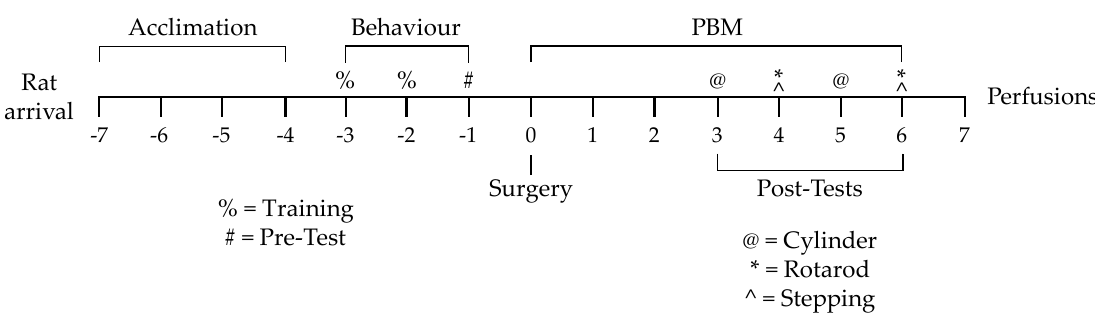
Figure 1. Experimental timeline from rat arrival to perfusion and tissue extraction. Numbers represent days from surgery day. PBM: transcranial near-infrared photobiomodulation.